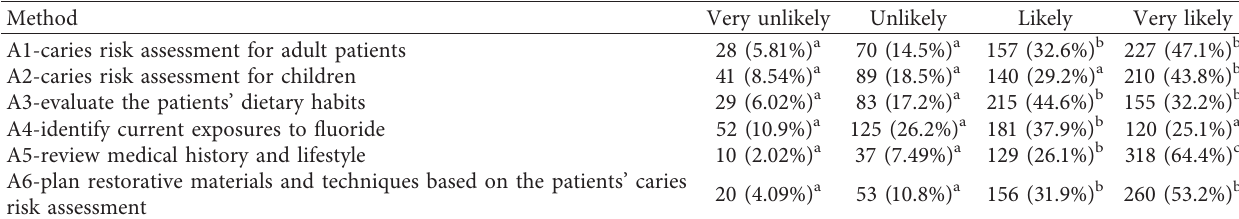
Table 3: Caries risk assessment